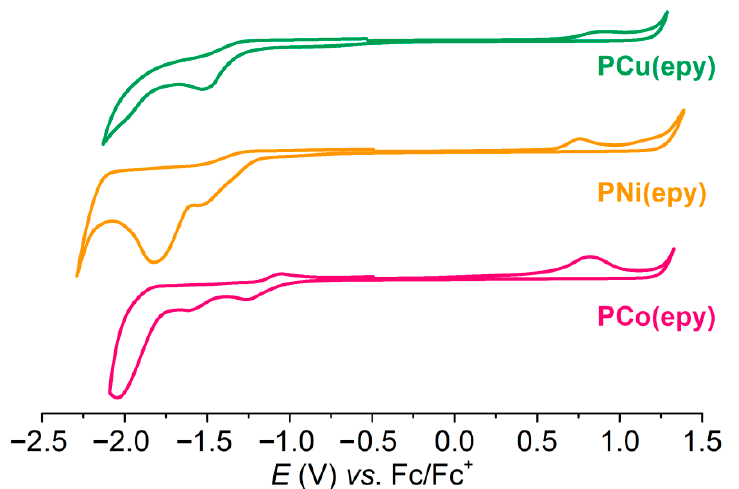
Figure 3. Cyclic voltammograms of PCo(epy) , PNi(epy) , and PCu(epy) in degassed CH 2 Cl 2 .